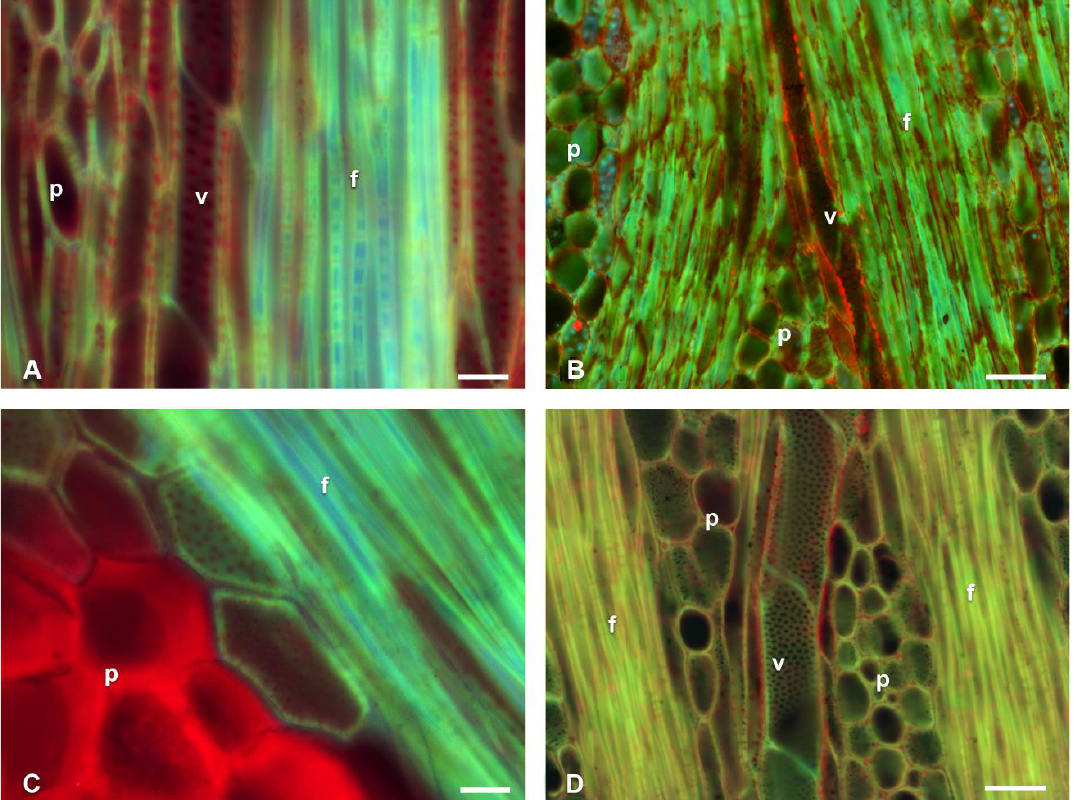
Figure 4. Fluorescence emission of longitudinal sections of fibrous wood species of Cactaceae. ( A ) Cylindropuntia kleiniae . ( B ) Cylindropuntia leptocaulis . ( C ) Opuntia stenopetala . ( D ) Leuenbergeria lychnidiflora . f = fibers, p = parenchyma, v = vessel. Scale: 20 µm: A,C; 50 µm: B,D.